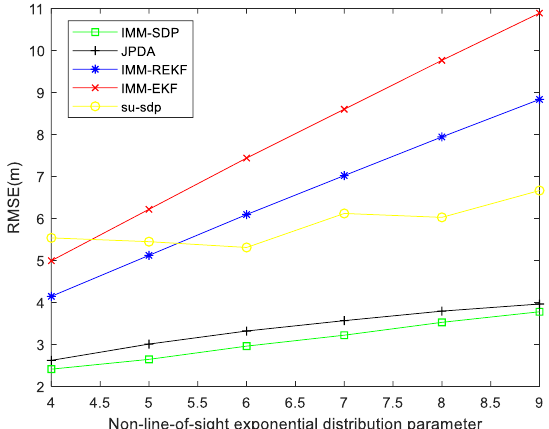
Figure 8. NLOS exponential distribution parameter .